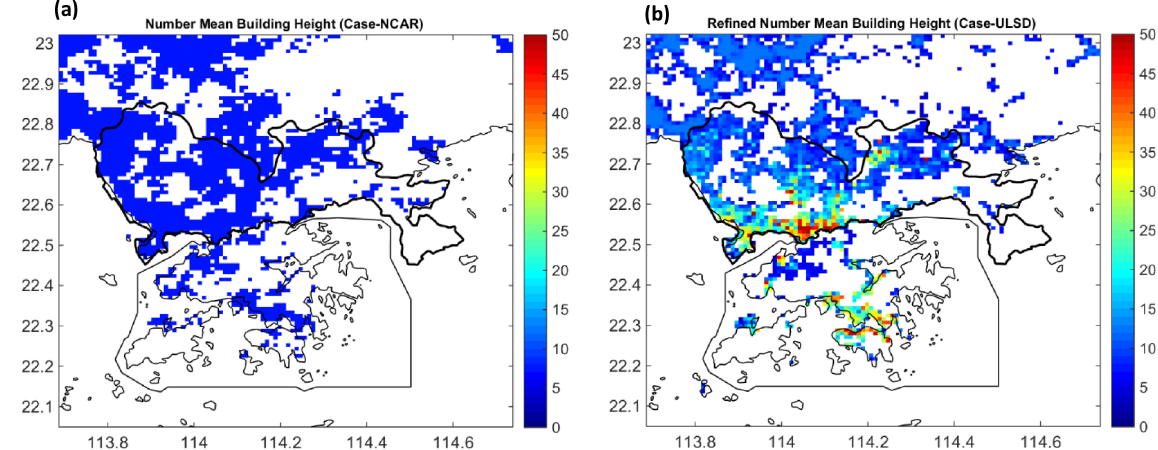
Figure 4. The number mean building height before (a) and after refinement (b) . Data source: Li et al. (2019a, b). For other urban morphology indicators, please refer to Sect. S1 of the